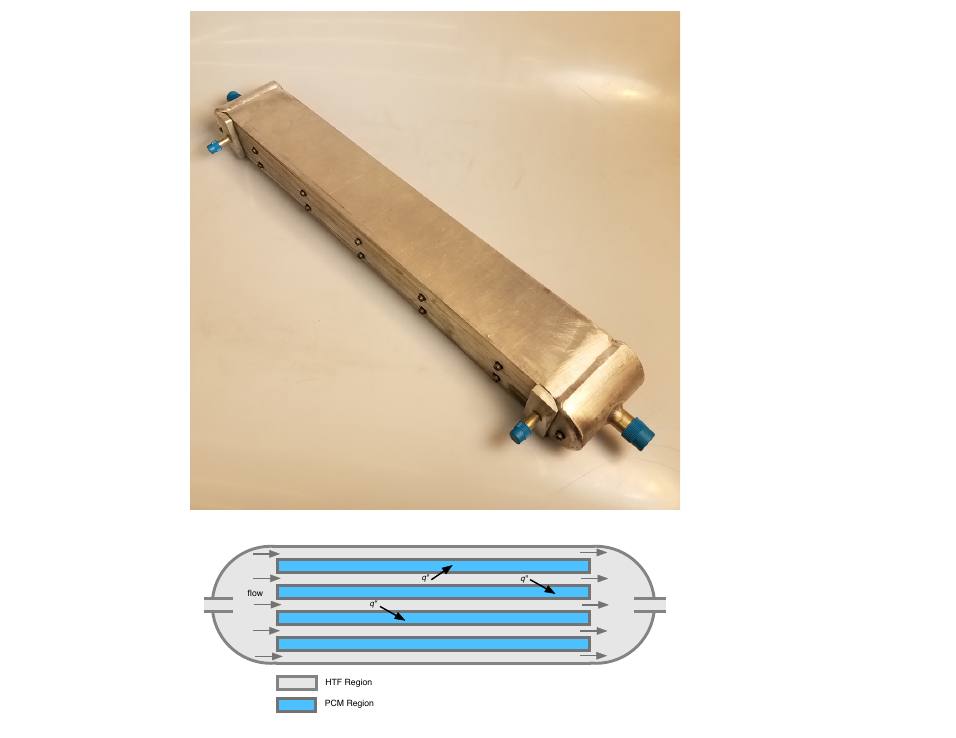
Figure 1. Photograph and schematic (not to scale) illustrating heat flux (q (cid:48)(cid:48) ) from hot heat transfer fluid (HTF) flow passages into phase change material (PCM) storage sections during melting process.